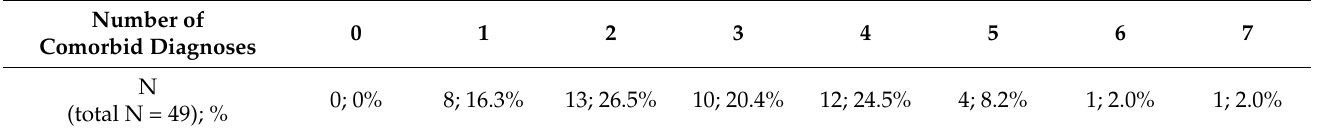
Table 2. Number of patients with several comorbid diagnoses in the sample.